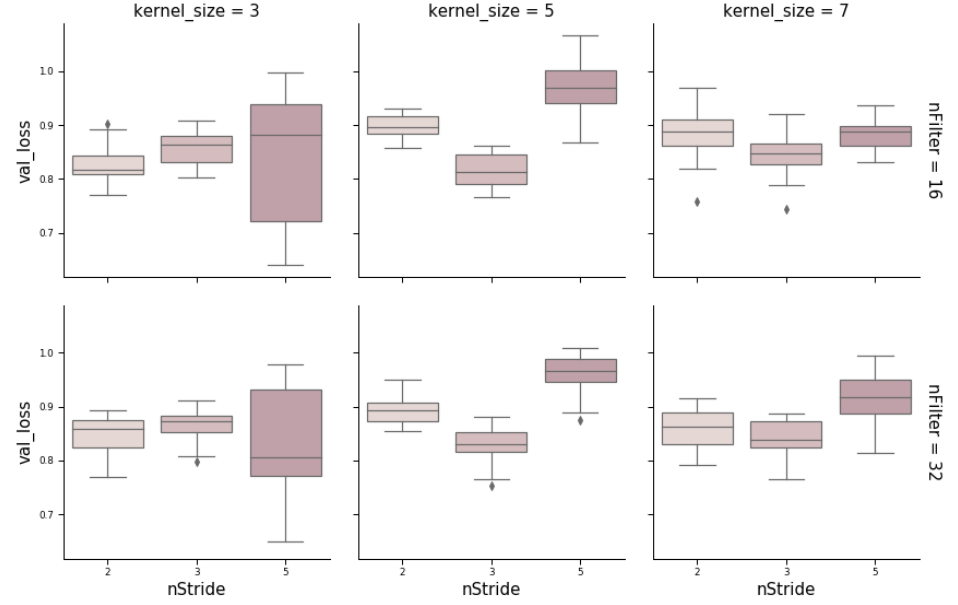
Figure 6. Box-plot representing loss values on the validation set with a convolutional neural network (CNN) architecture using different kernel sizes (3, 5, and 7), strides (1, 2, and 5), and number of filters (16 and 32).